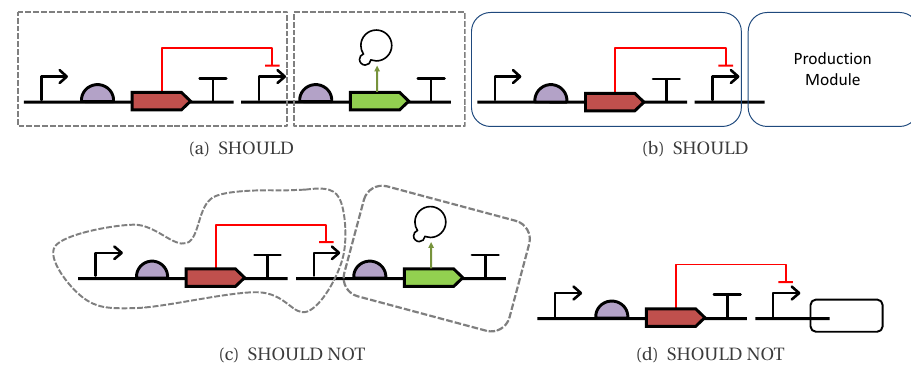
Figure 23: Examples of recommended and problematic module boundaries: (a) two modules with visually distinct rectangular borders, (b) shows the same modules but with rounded rectangles and the second being a “black box” module with no internal structure shown, (c) shows modules with non-rectilinear borders, and (d) shows a black-box module that is not visually distinct from a sequence feature glyph.